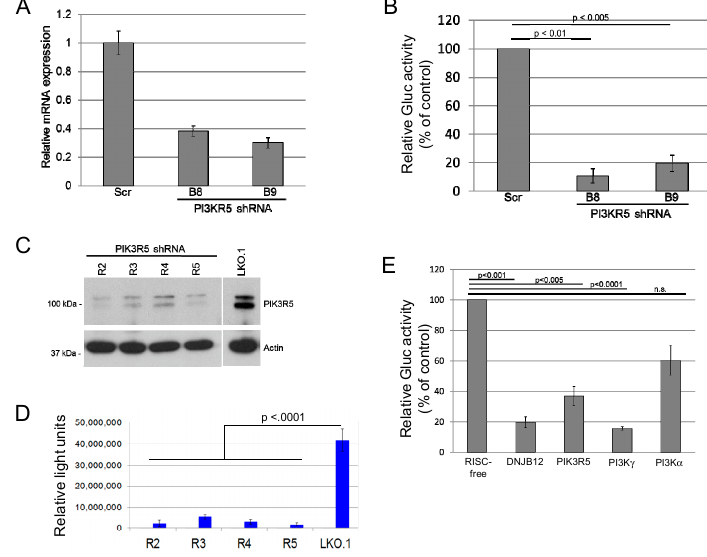
Figure 1. Phosphoinositide 3 ′ -kinase γ (PI3K γ ) knockdown inhibits JC polyomavirus infection. ( A ). SVG-A cells were infected with LKO lentivirus expressing control scrambled shRNA or an shRNA (B8 or B9) targeting PK3IR5 and selected with puromycin. PIK3R5 mRNA levels in puromycin-